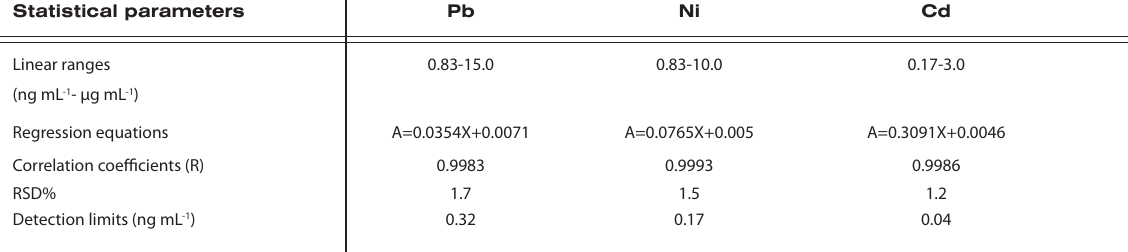
Table 4. Analytical parameters of the method Statistical parameters